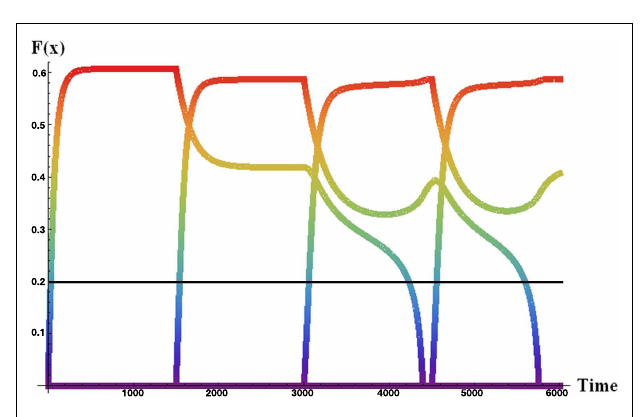
FIGURE 2 | Noiseless activation trajectories for four sequentially received data in the dynamic activation-based buffer. Each item presented to the buffer for 1500 iterations. F ( x ) = memory